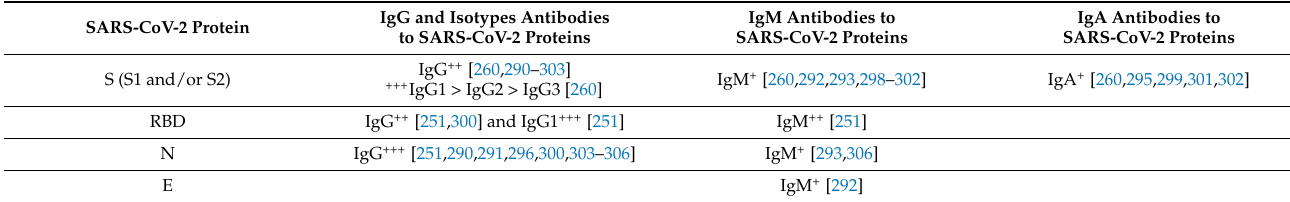
Table 6. Antibodies to SARS-CoV-2 in COVID-19